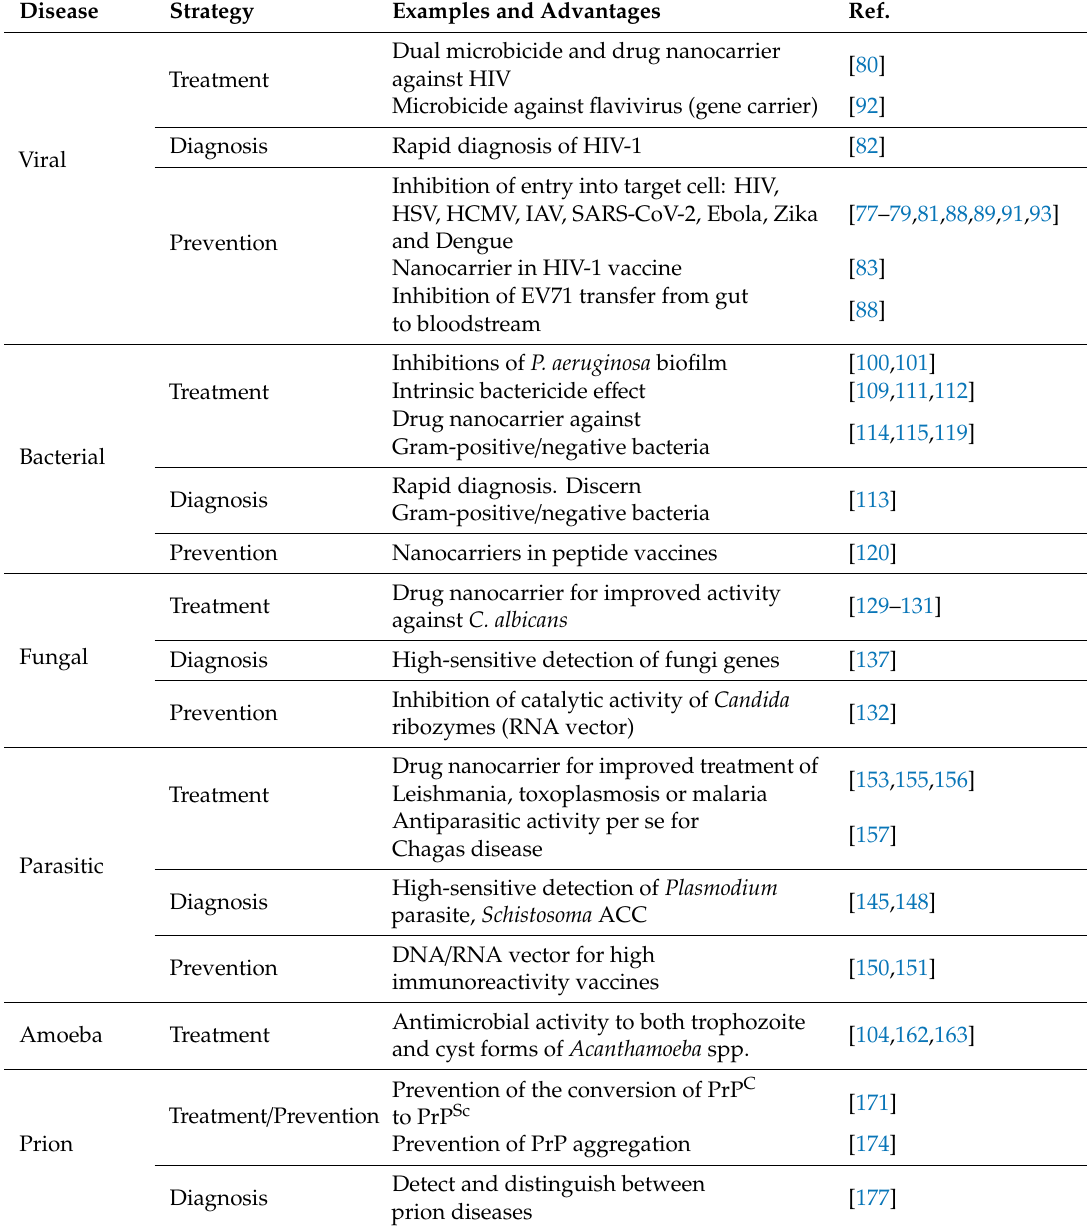
Table 1. Overview of the potential of dendrimers and dendritic materials in the fight against infectious diseases, including selected